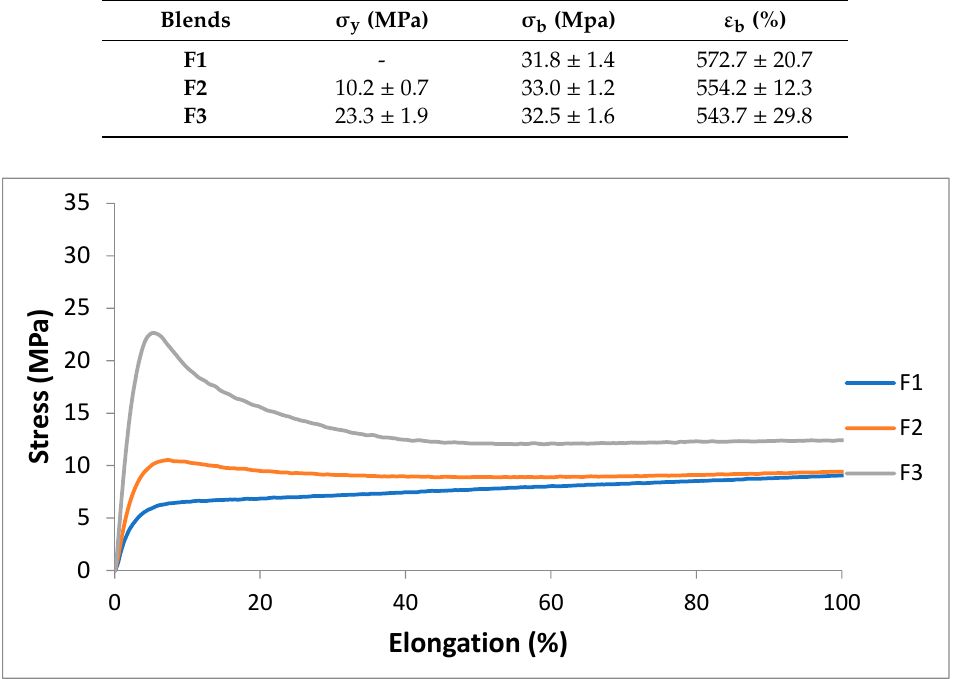
Figure 5. The first part of stress / strain curves (up to 100% of elongation) of F1, F2, F3.